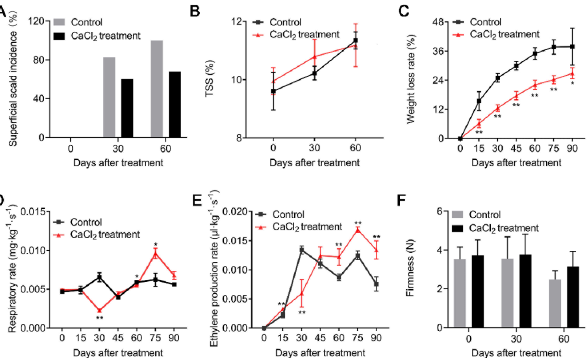
Figure 1. Effect of CaCl 2 treatment on the superficial scald incidence, TSS content, weight loss rate, respiratory rate, ethylene production rate, and firmness of ‘Chili’ pear fruit. Superficial scald incidence ( A ) and TSS content ( B ) of fruit at 0, 30, and 60 d after treatment. Weight loss rate ( C ), respiration rate ( D ), and ethylene production rate ( E ) of fruit at 0,15, 30, 45, 60, 75, and 90 d after treatment. ( F ) The firmness of fruit at 0, 30, and 60 d after treatment. Data are given as mean ± SD (n = 3) .